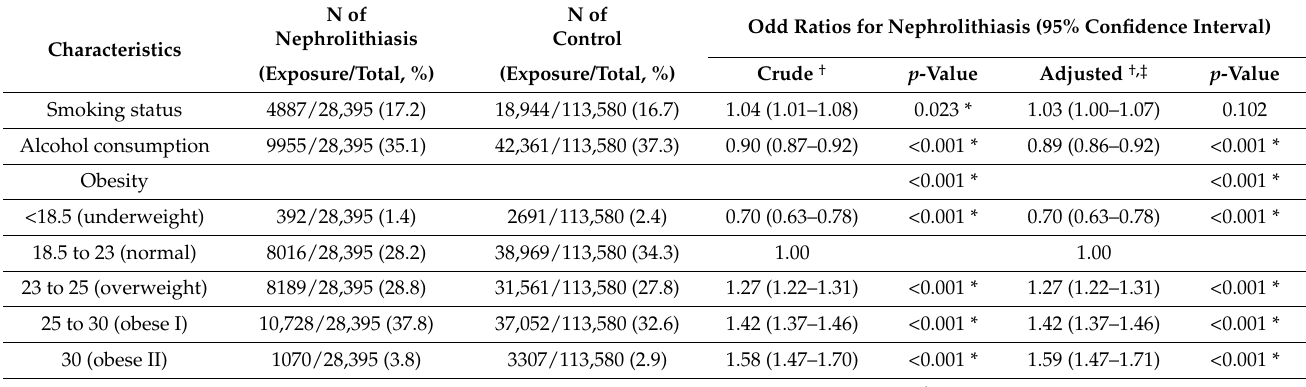
Table 2. Crude and adjusted odd ratios (95% confidence intervals) of smoking, alcohol consumption, and obesity for